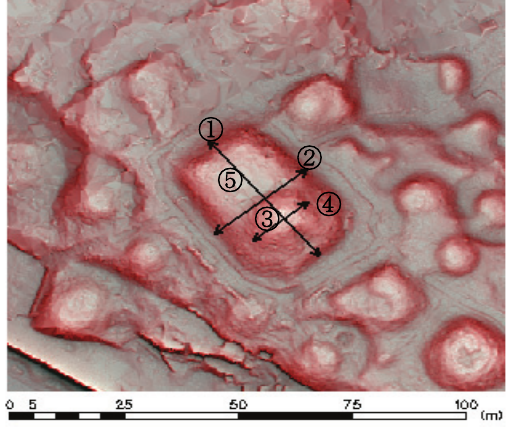
Fig13. A New tomb shape (RRIM of Lidar data) Table 3. Length of a Confirmation of a new tomb shape